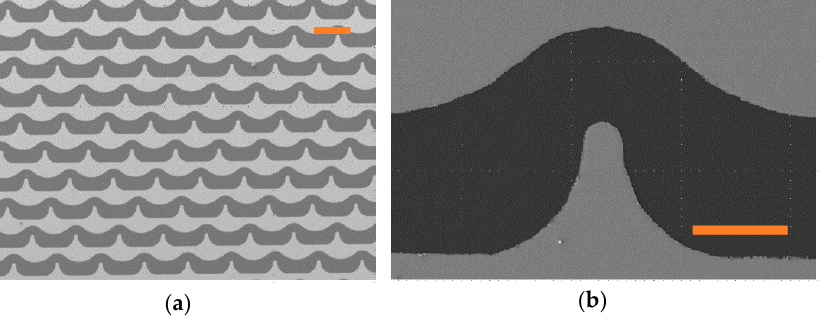
Figure 1. Interdigitated electrodes were used in the experiments. ( a ) Microelectrode array image obtained with a 10× objective with an orange scale bar that indicates 200 µm. ( b ) Microelectrode array image obtained with a 40× objective with an orange scale bar that indicates 50 µm.